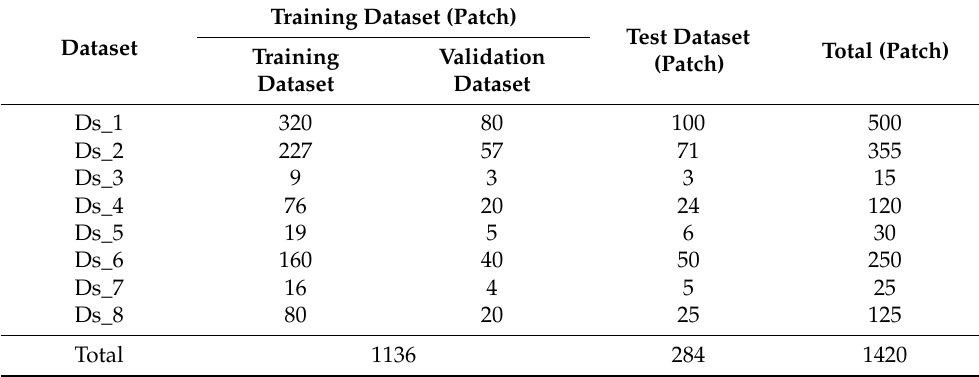
Table 1. Eight different types of scraping image patch datasets.